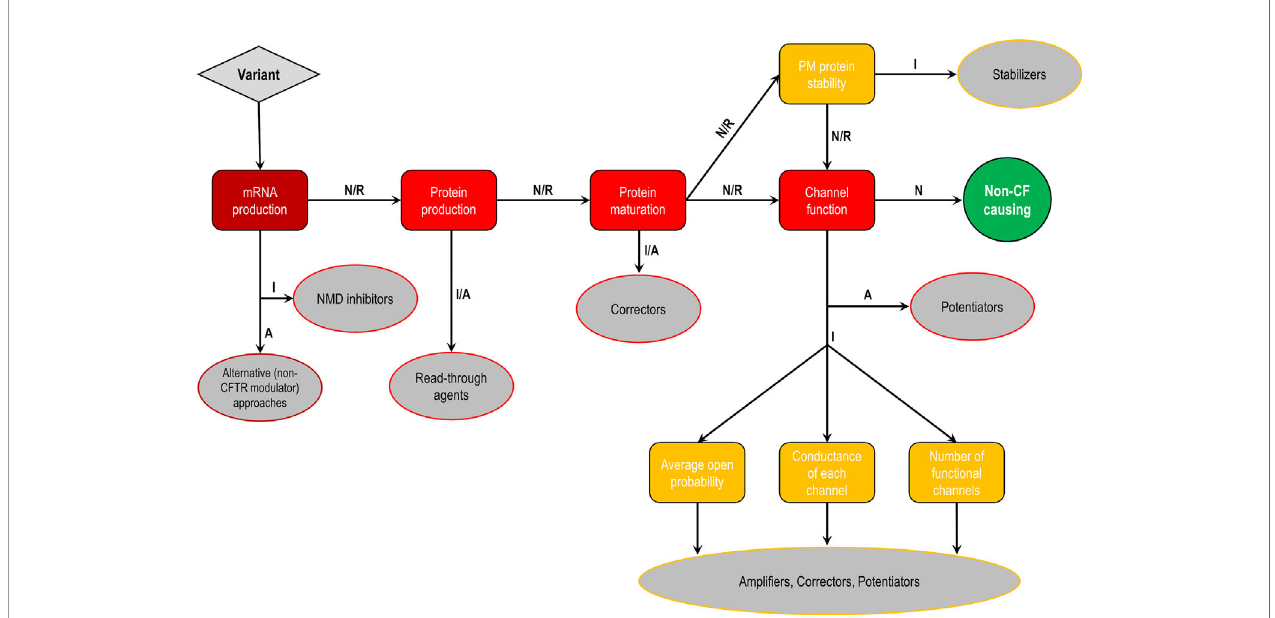
FIGURE 5 | Cellular and molecular defects and potential CF transmembrane conductance regulator (CFTR) modulator approaches. Flowchart demonstrating the steps to identify each cellular and molecular defect of a CFTR gene variant and potential therapeutic approaches to correct each of these defects. Abbreviations: A, abrogated; I, impaired; N, normal; R,